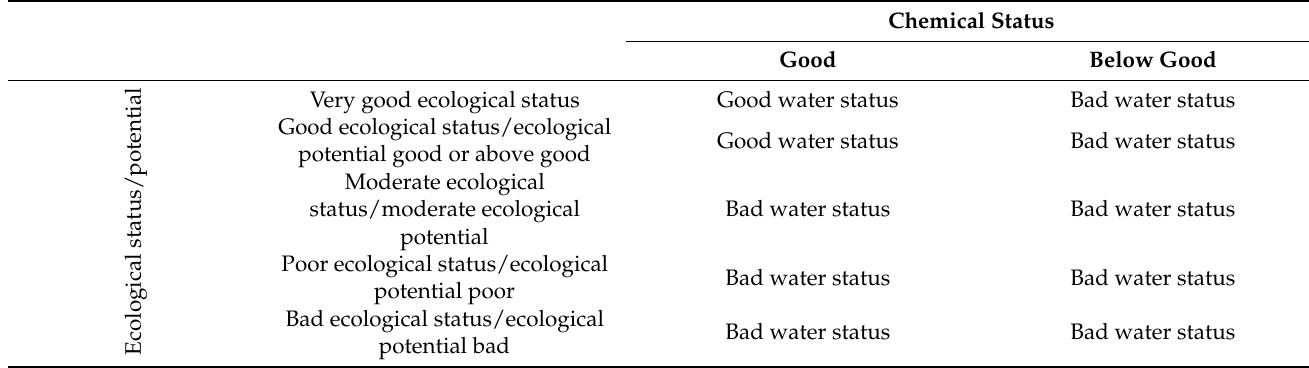
Table 1. Assessment of surface water quality in